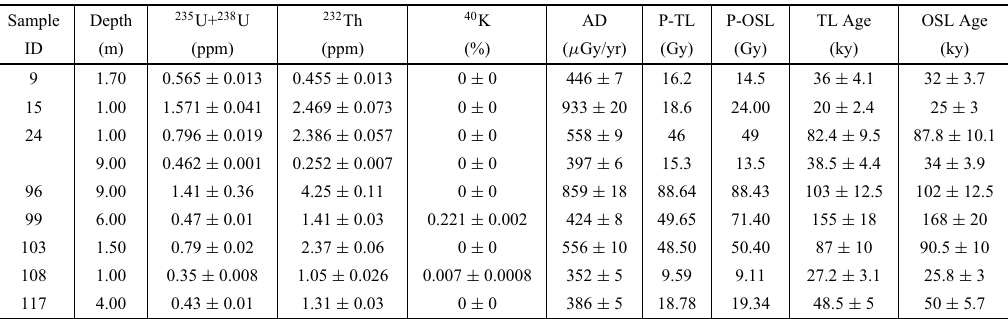
Sample numbers, natural radioactivity, paleodoses (P), annual doses (AD), and ages by TL and OSL for samples from alluvial